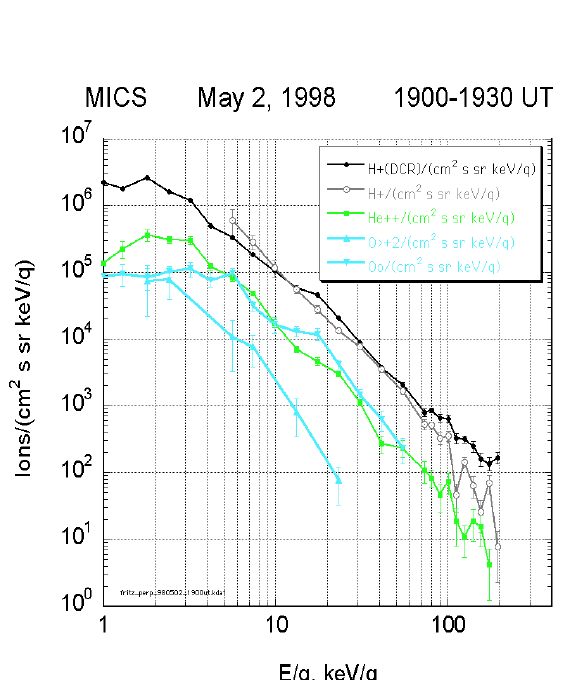
Fig. 6. Display of the ion composi- tion direct event data for the period of Fig. 2 using only those data that pro- duce a valid time-of-flight (TOF) with- out a companion valid energy response.